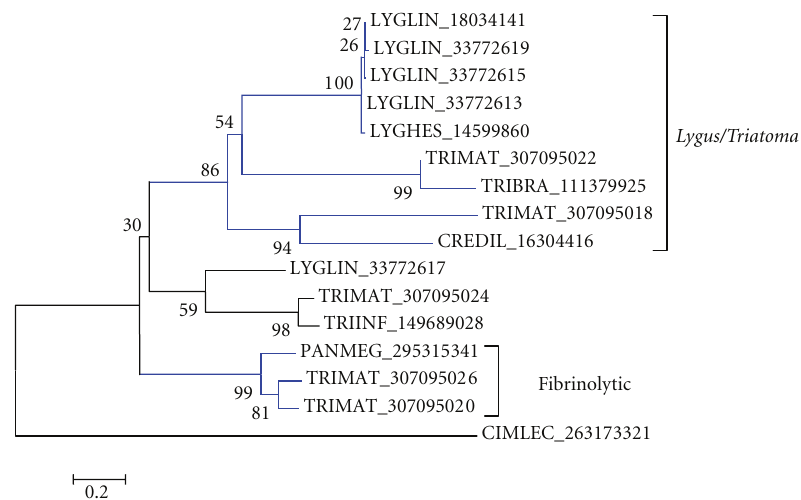
Figure 2: Phylogram of the salivary serine proteases of Cimicomorpha. See the legend of Figure 1 for more